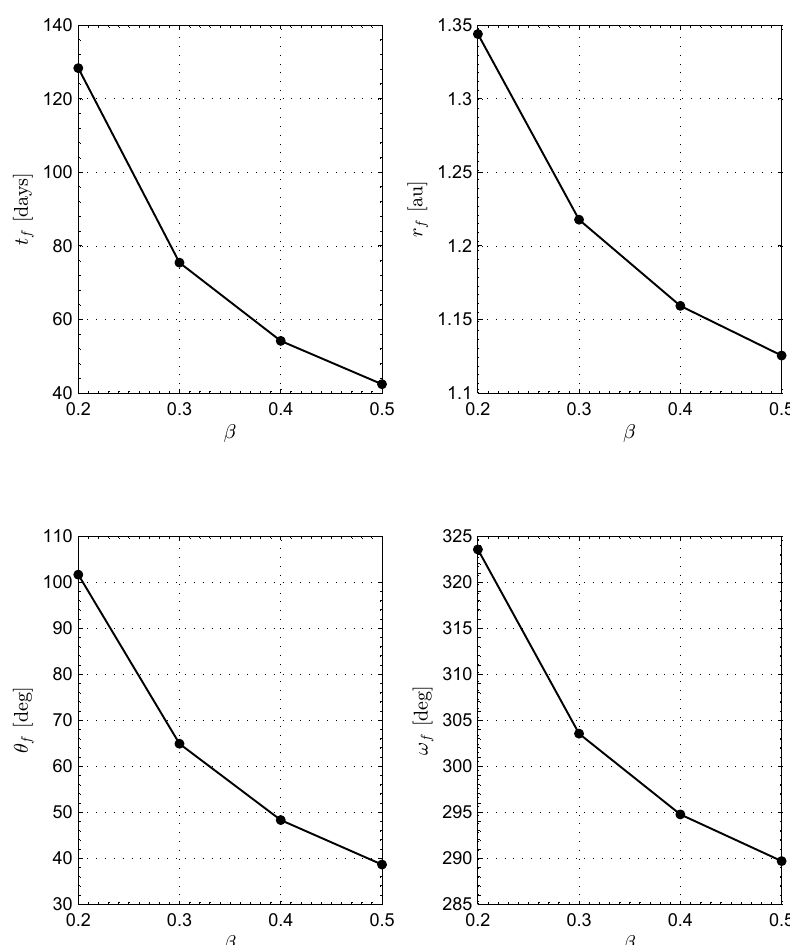
Figure 10. Optimal transfer performances in a Mars-based mission scenario ( e f = 0.3438) as a function of β .